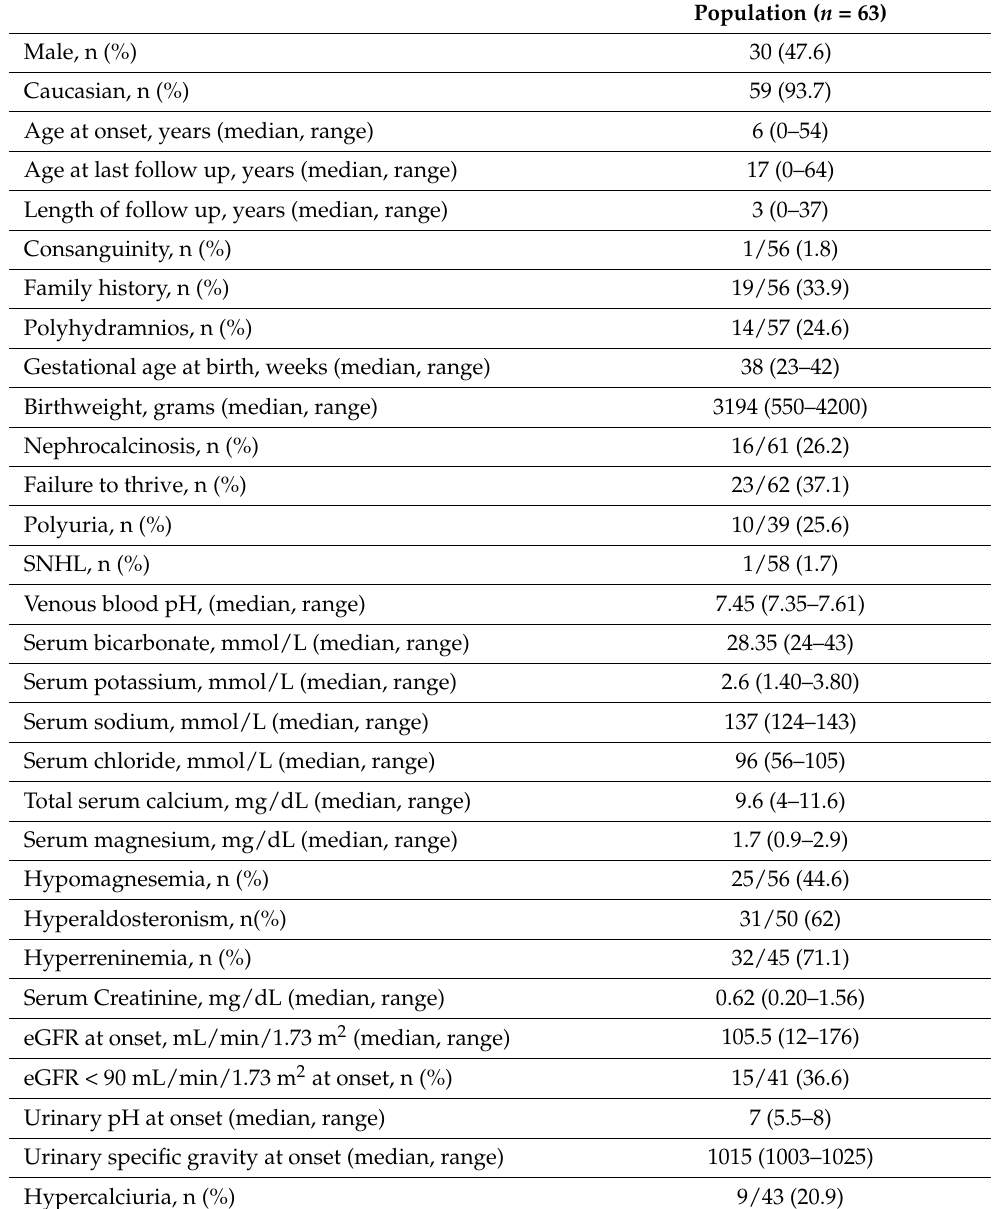
Table 1. Summary of clinical and biochemical features of the patients included in the